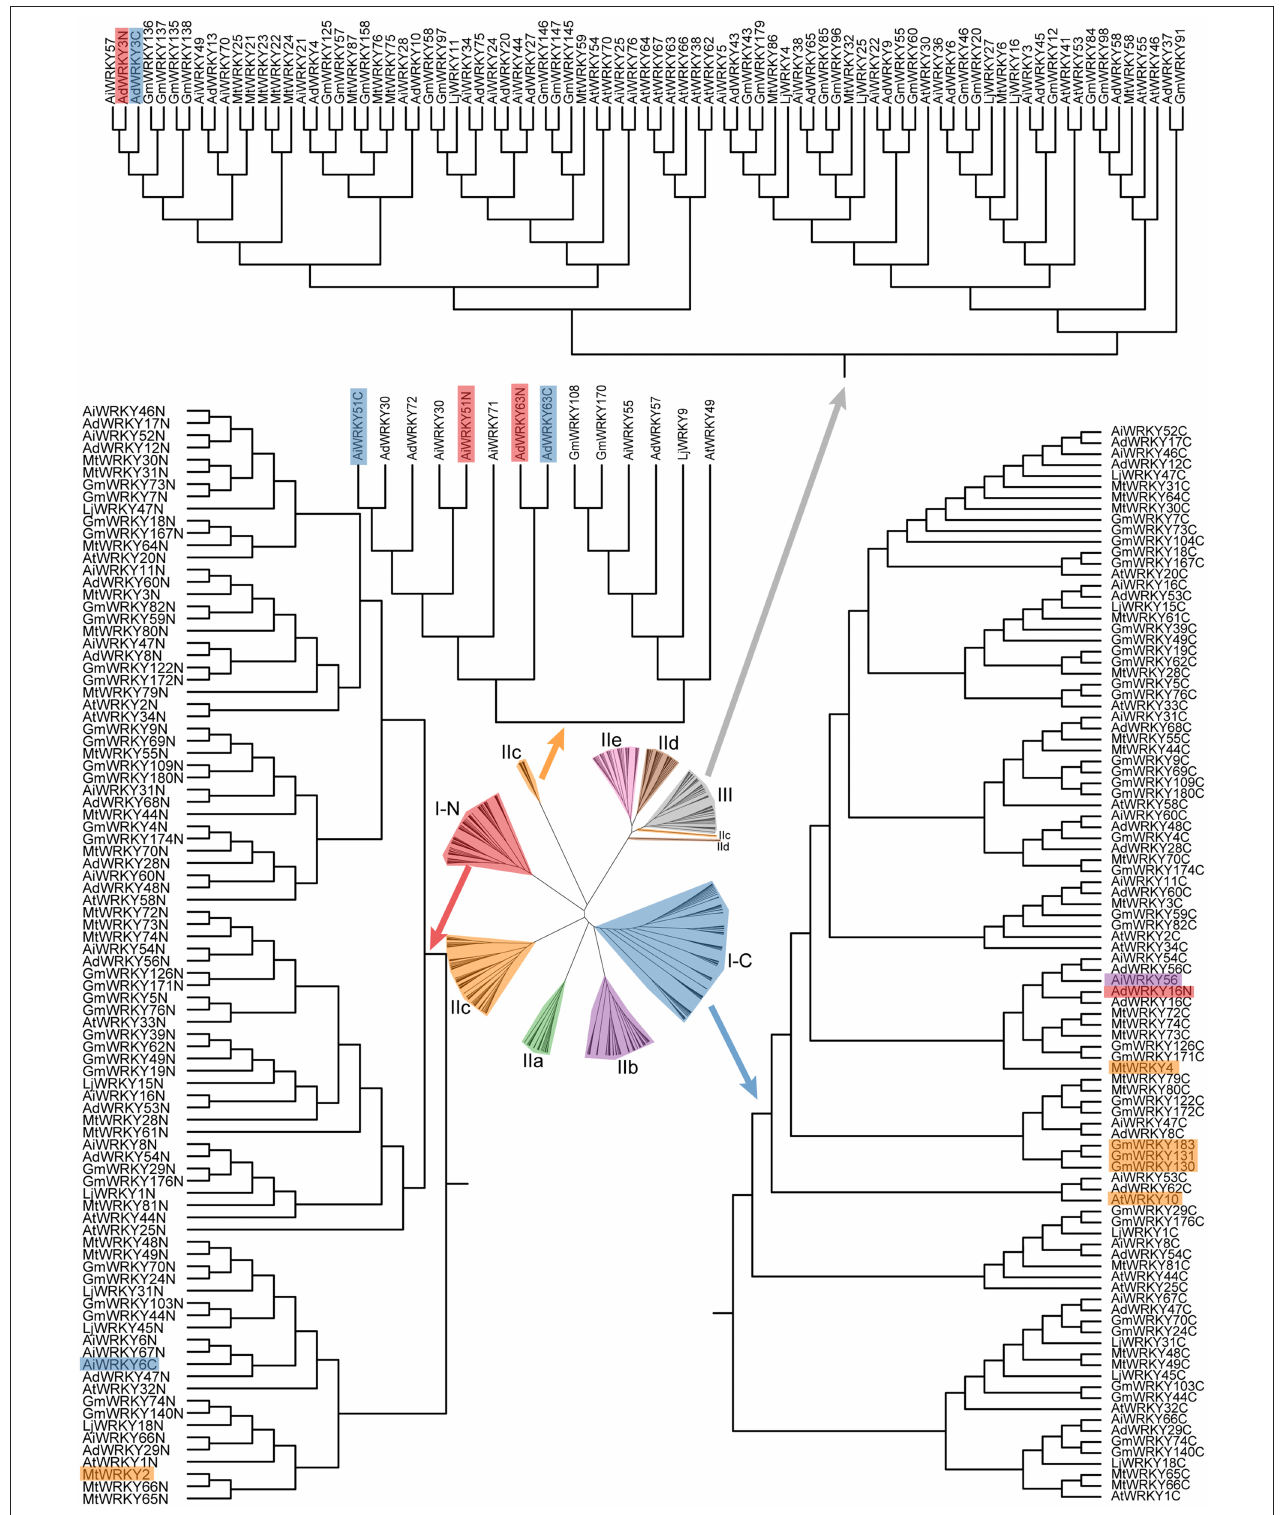
FIGURE 1 | Phylogenetic tree of WRKY domains in six plants. The phylogenetic tree was constructed using MEGA 6.0 by the Neighbor-Joining (NJ) method with 1000 bootstrap replicates.